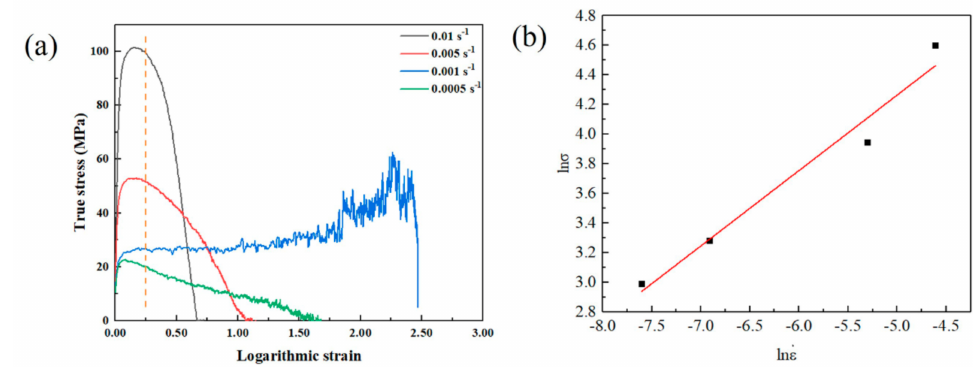
Figure 3. ( a ) The true stress-logarithmic strain curves of Mg-Re alloy at 400 ◦ C (taking the logarith- mic strain at 0.25 for calculating the value of m); ( b ) Plot of the logarithm of tensile stress versus logarithmic strain rate to determine the strain rate sensitivity